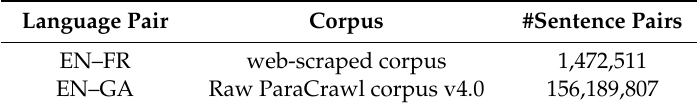
Table 3. Overview of the corpora used for extrinsic evaluation of